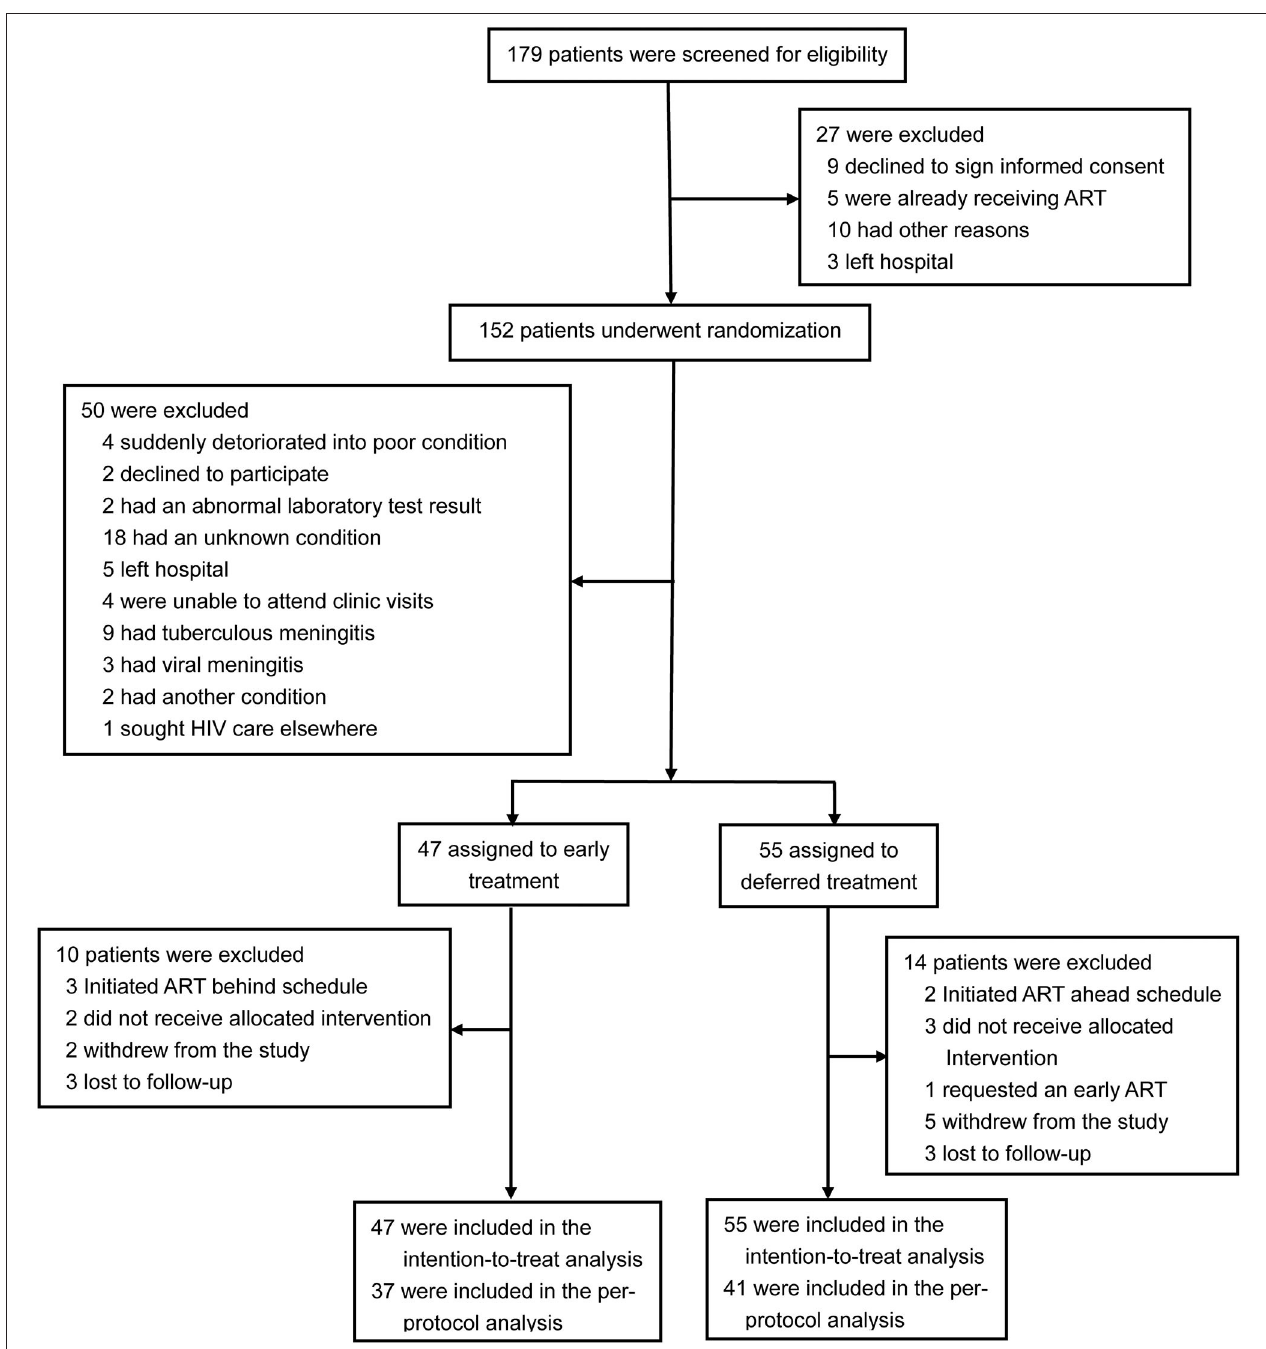
FIGURE 1 | The flow diagram of the study.